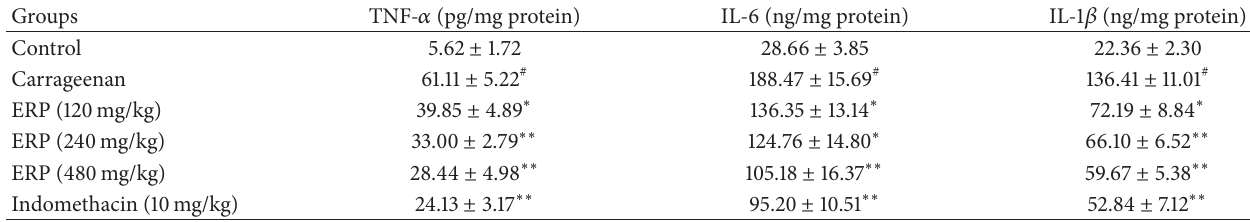
Table 1: Effect of ERP on carrageenan-induced the levels of TNF- 𝛼 , IL-6 and IL-1 𝛽 in mouse paw edema.